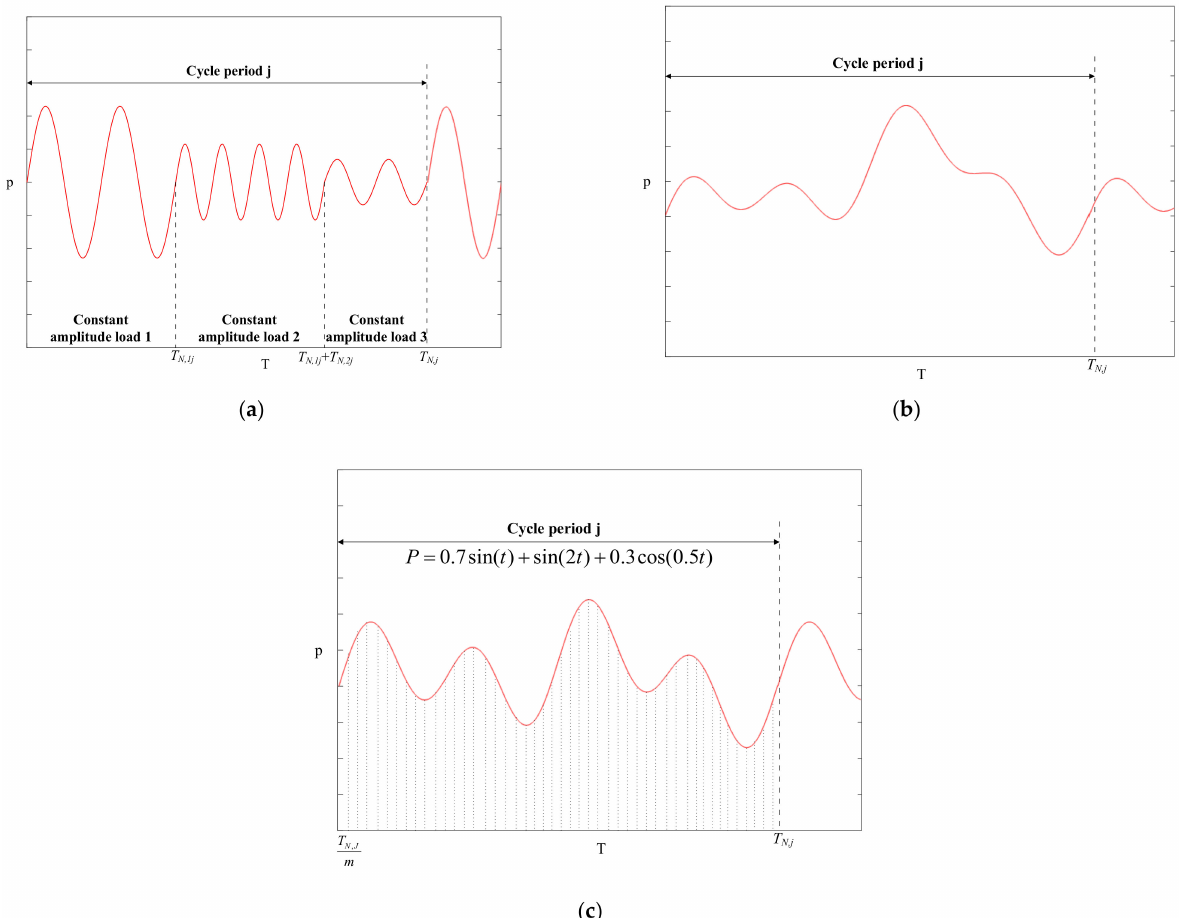
Figure 1. Schematic diagram of variable amplitude load: ( a ) type 1, ( b ) type 2, ( c ) type 3. 1. Type 1 variable amplitude load; Suppose there are m constant amplitude loads with different amplitude sizes in the j- th cycle. The total load action time is T N,j and each constant amplitude load action time is T N,ij . The number of load cycles for